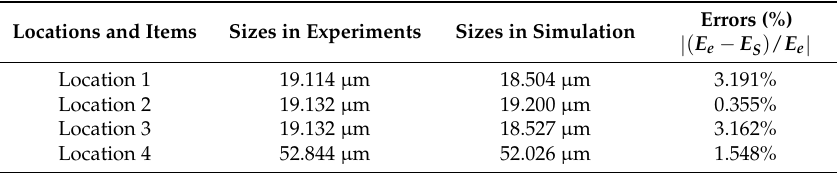
Table 3. Typical results of deeps trenches in different locations.